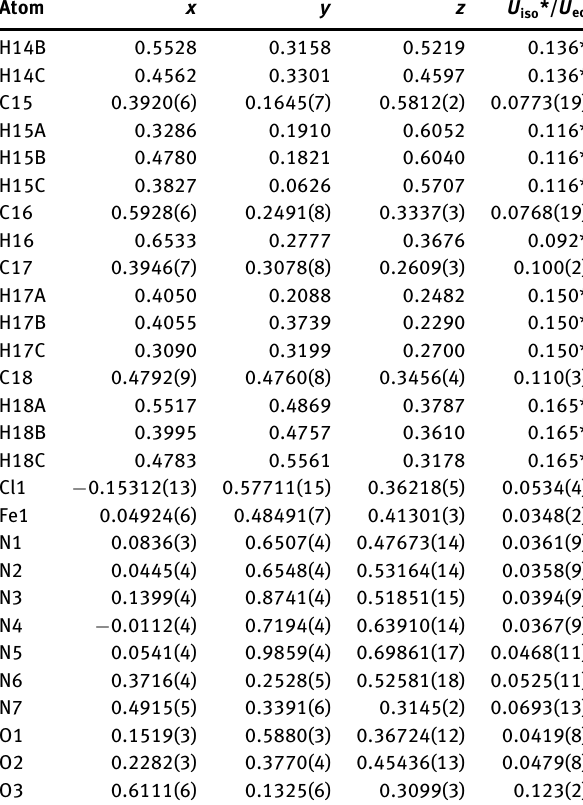
Hydrogenatomswereincludedintherefinementatcalculated positions [C—H aromatic = 0.93 Å] and treated as riding models with U iso (H) = 1.2 U eq